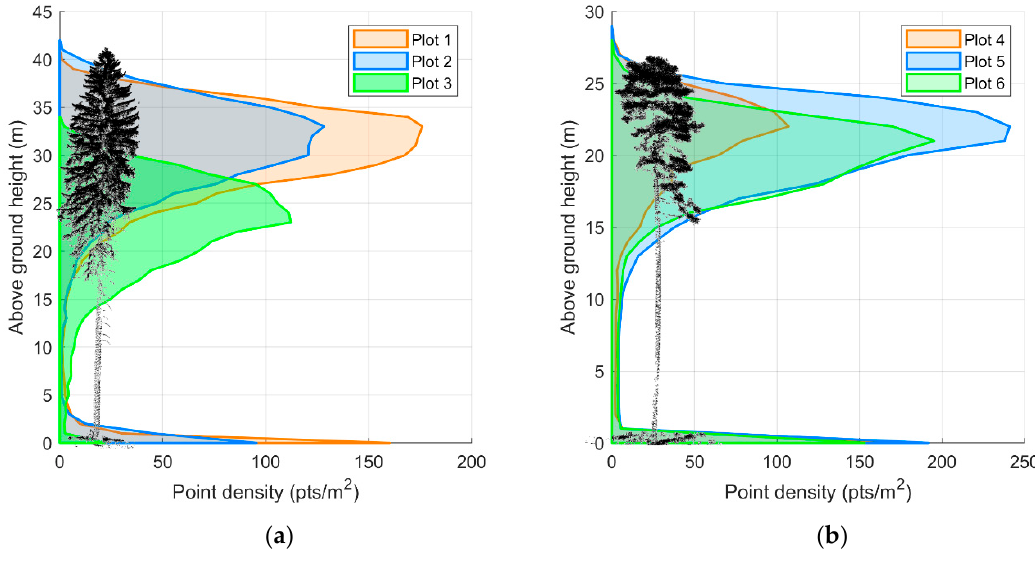
Figure 4. Point densities in spruce ( a ) and pine ( b ) plots. Histograms represent average point counts per square meter in 1 m thick horizontal layers; only points classified as nonground are displayed.